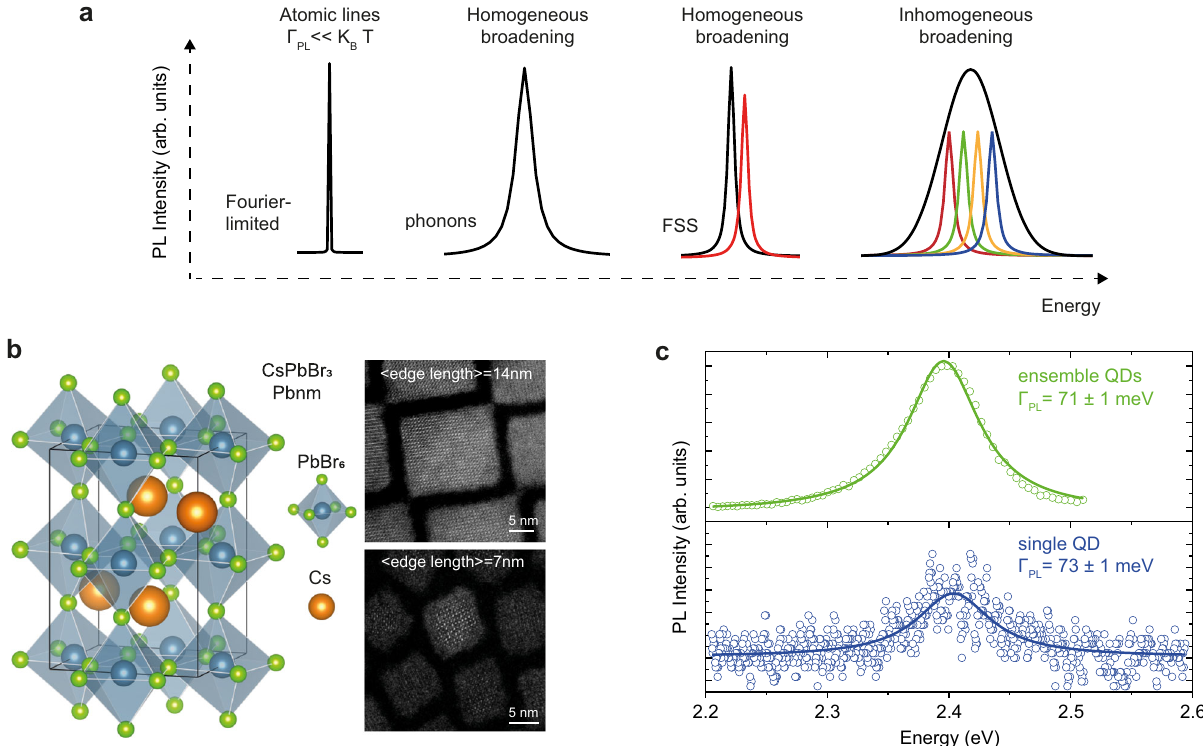
Fig. 1 Emission line-broadening in nanomaterials: the case of perovskite compounds. a A sketch of different emission line-broadening mechanisms ( Γ PL is the linewidth, k B T the thermal energy, and FSS the fi ne structure splitting). b Schematic of the CsPbBr 3 crystal structure with two HAADF-STEM images, representing the two studied QD batches with mean edge lengths of 7 and 14 nm, respectively. c Room-temperature emission spectra at the ensemble and single particle levels. Both PL spectra feature similar emission line-broadening. Solid lines are best fi ts of a Lorentzian function to the experimental data (colored open